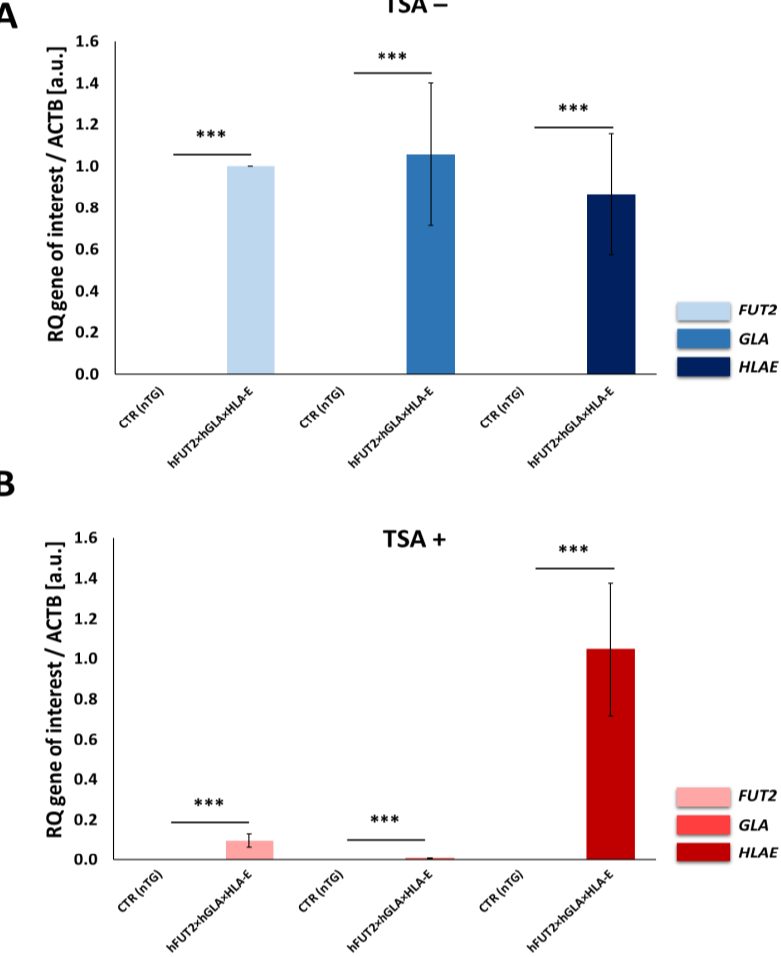
Figure 2. RT-qPCR analysis of the relative expression of human genes: h FUT2 , h GLA and HLA-E in porcine triple-transgenic (3 × TG) ACFCs epigenetically not transformed ( A ) or transformed ( B ) with trichostatin A (TSA − and TSA+, respectively). The p ACTB gene encoding porcine β -actin was used as endogenous reference gene. The bar graphs show the mean ± SEM. Statistics: one-way ANOVA and Newman–Keuls post hoc test. The bars marked with different letters vary significantly; values denoted as *** p < 0.001. The numbers of biological replicates (i.e., numbers of 3 × TG and CTR nTG pigs serving as independent biological donors) ≥ 3. Number of technical replicates = 3 (within each biological